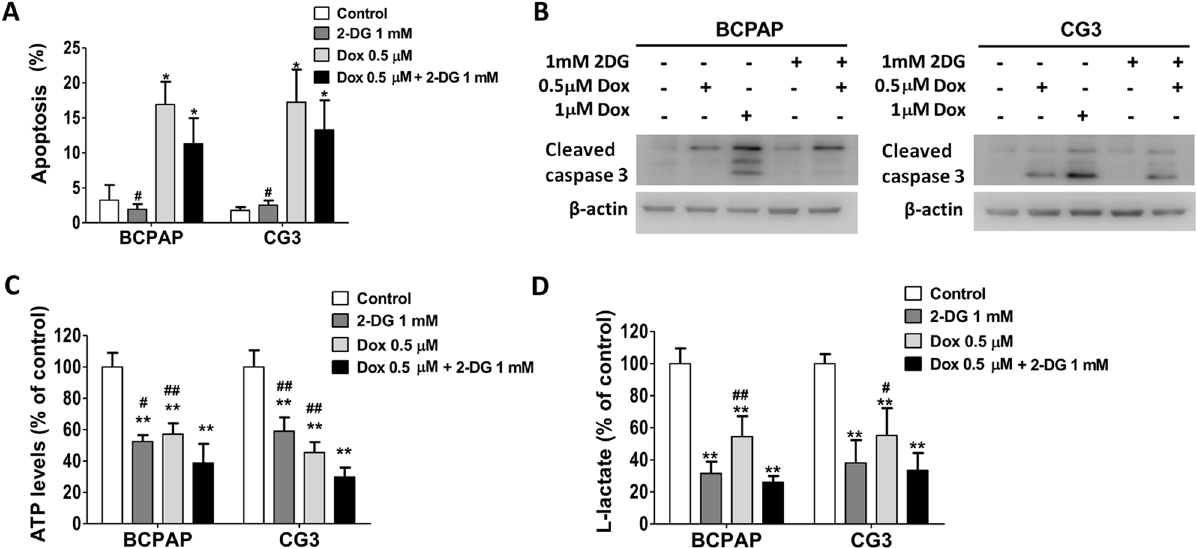
Fig 6. Effects of 2-DG, doxorubicin, or both on apoptosis and metabolic dysfunction in PTC cells. (A) The effect of 2-DG, doxorubicin, or both on apoptosis in BCPAP and CG3 cells. The two cell lines were cultured in medium supplemented with 10% fetal bovine serum and then treated for 48 h with 1 mM 2-DG, 0.5 μ M doxorubicin, or both. Apoptosis was examined using propidium iodide (PI)/annexin V staining and flow cytometry; PI − /annexin V + cells were defined as apoptotic cells. (B) The expression of cleaved caspase 3 in BCPAP and CG3 cells treated for 48 h with 2-DG, doxorubicin, or both. (C) Intracellular ATP levels and (D) extracellular L -lactate production in cells treated for 48 h with 1 mM 2-DG, 0.5 μ M doxorubicin, or both. * p < 0.05, ** p < 0.001, compared to the controls ( t test); # p < 0.05, ## p < 0.001, compared to 2-DG plus doxorubicin treatment ( t test). Data are presented as means ± standard deviation